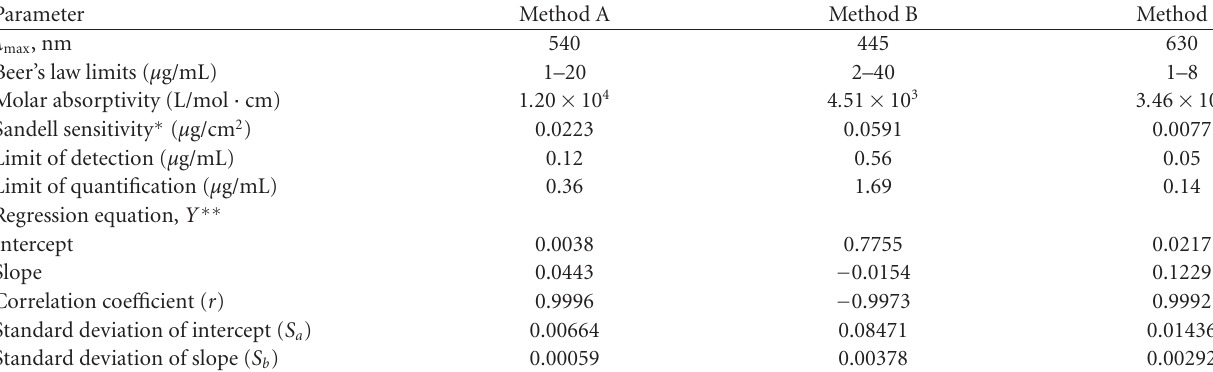
Figure 3: E ff ect of acid on the color development of the measured species for the proposed methods. Table 2: Regression and analytical